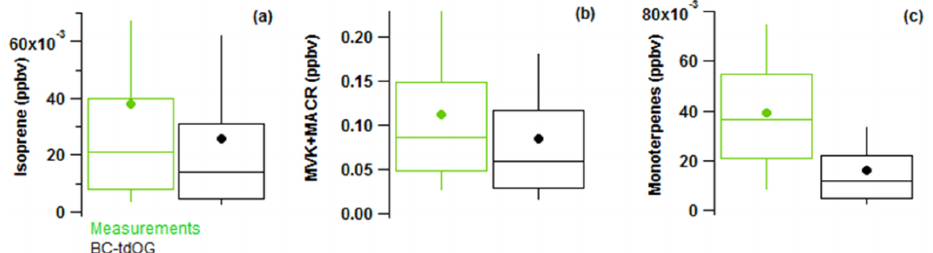
Figure 6. Comparison of the measured and WRF-Chem-predicted (top-down O&G emission scenario) mixing ratios of isoprene (a) , methyl vinyl ketone (only available in measurements) and methacrolein (b) , and monoterpenes (c) in the Front Range boundary layer. Box and whisker plots depict the 10th, 25th, 50th, 75th, and 90th percentiles. Mean values are shown in circles.